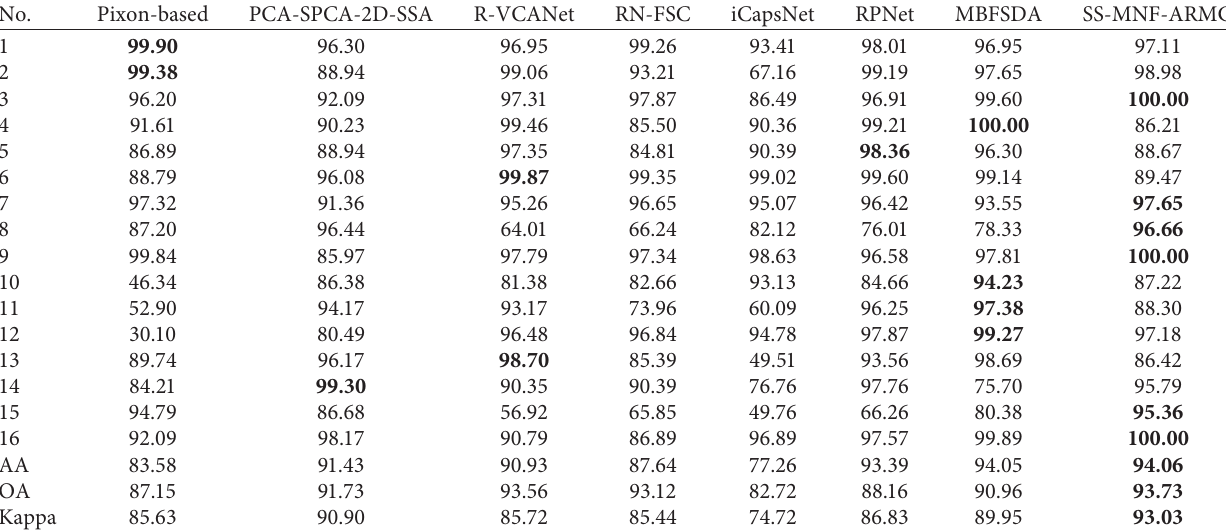
Table 7: Classification results of different techniques for the Salinas dataset (16 classes).